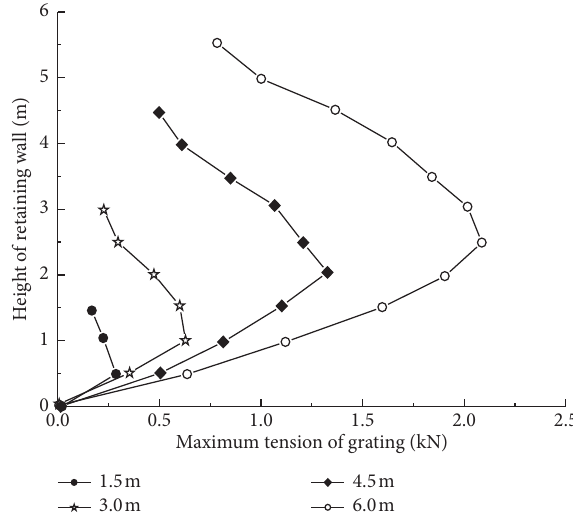
Figure 12: Variation of the maximum tensile force of the grille along the wall height.